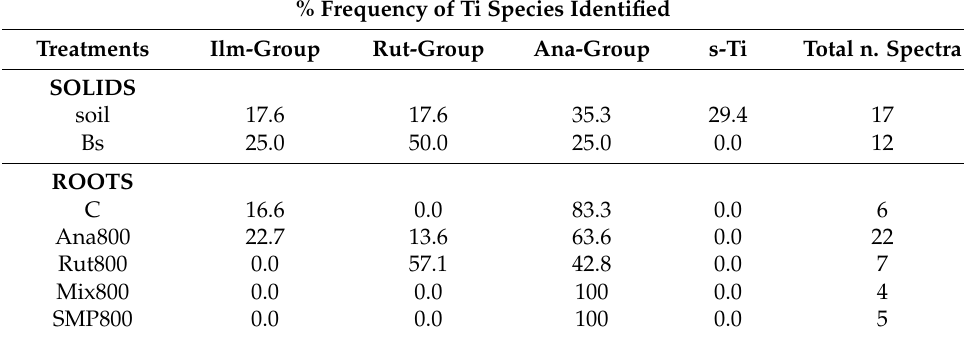
Table 1. Total number of µ XANES spectra and % frequency of identified Ti species in the soil, biosolid, and root samples. % Frequency of Ti Species Identified Treatments